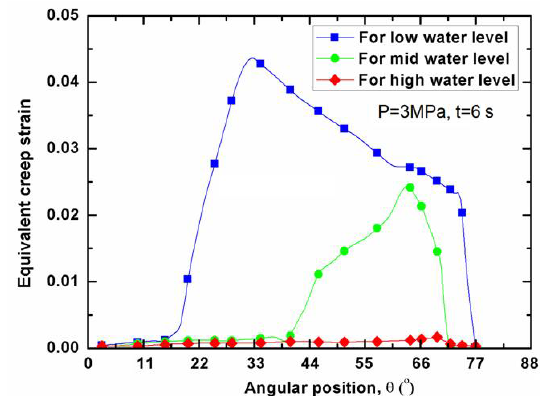
Figure 14. Comparison of creep distributions for RPV with various water levels under P =